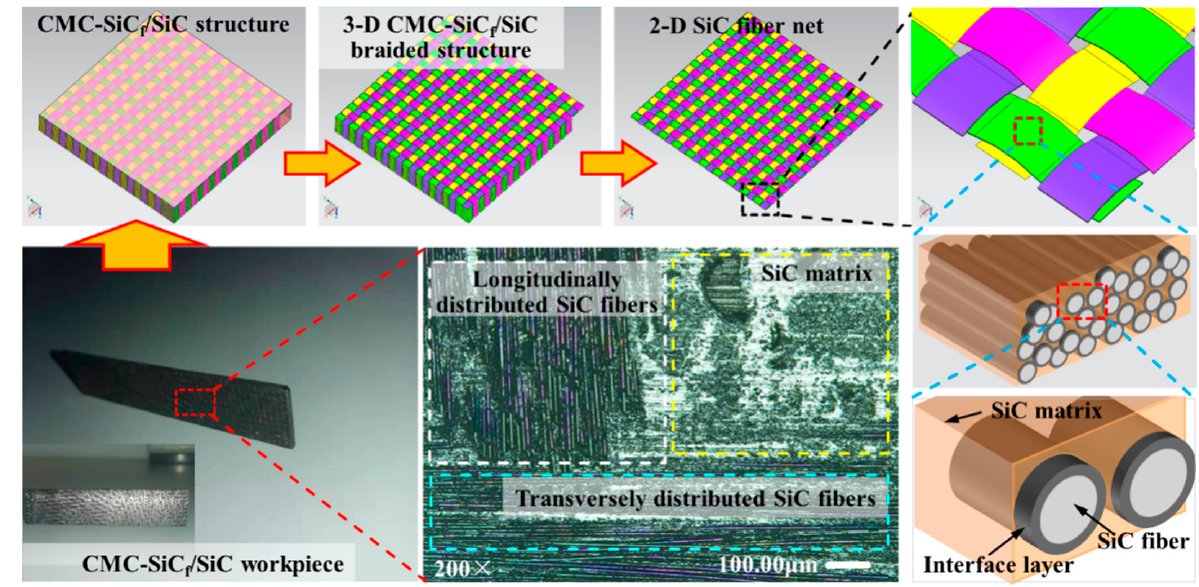
Figure 1. The structure and the surface morphology of CMC-SiC f /SiC.